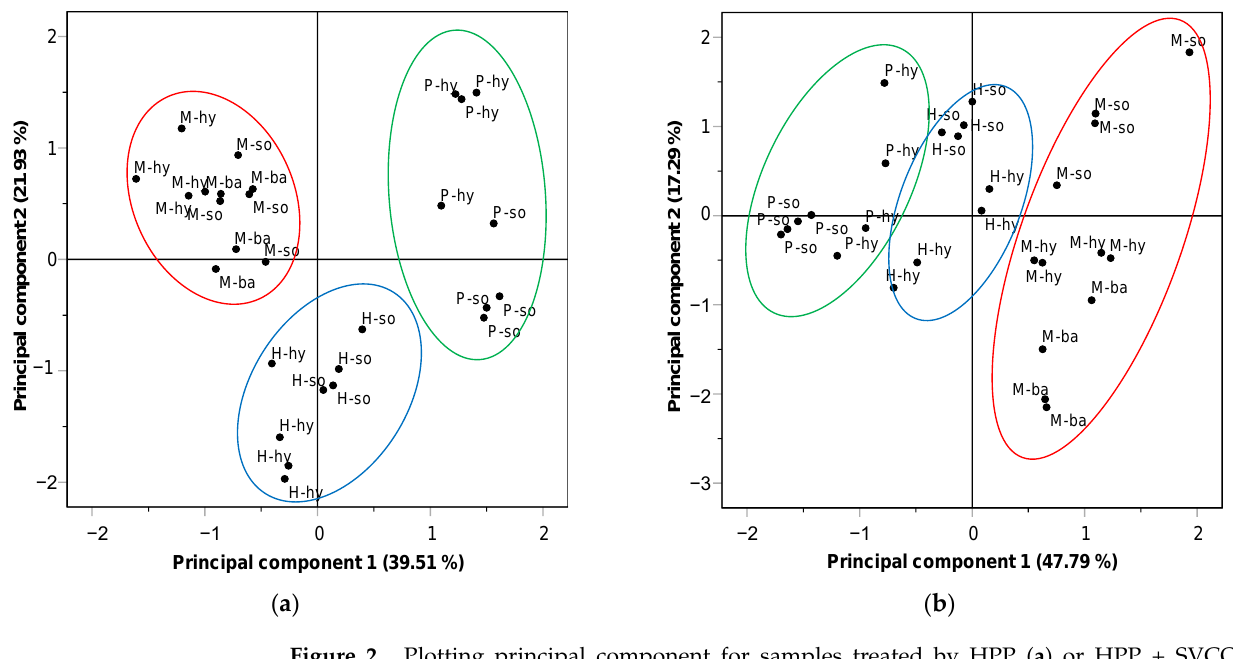
Figure 2. Plotting principal component for samples treated by HPP ( a ) or HPP + SVCOOK ( b ) according to protein matrix (M = meat-based patty; H = hybrid patty; P = plant-based patty) and fat replacement ( ba : backfat; hy : hydrocolloid emulsion; so : soya emulsion).